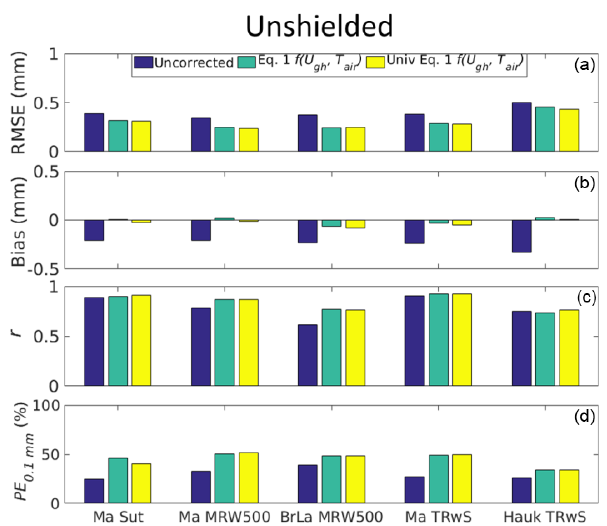
Figure 4. (a) Root mean square error (RMSE), (b) bias, (c) cor- relation coefficient ( r) , and (d) the percentage of events with er- rors less than 0.1mm (PE 0 . 1mm ) calculated from the difference be- tween the 30min precipitation measurements from the corrected, unshielded gauges and the DFAR. The Sutron from Marshall (Ma Sut), the MRW500 from Marshall (Ma MRW500) and Bratt’s Lake (BrLa MRW500), and the TRwS 405 from Marshall (Ma TRWS) and Haukeliseter (Hauk TRWS) are included. Uncorrected mea- surements are also shown (uncorrected – dark blue). Measurements adjusted using an example transfer function (Eq. 1) fit to precip- itation, air temperature ( T air ) and gauge height wind speed ( U gh ) are shown in green. Statistics describing these measurements ad- justed using the “universal” unshielded transfer function (Univ. Eq. 1 – yellow), which were based on independent Eq. (1) coefficients derived in K2017a, are also